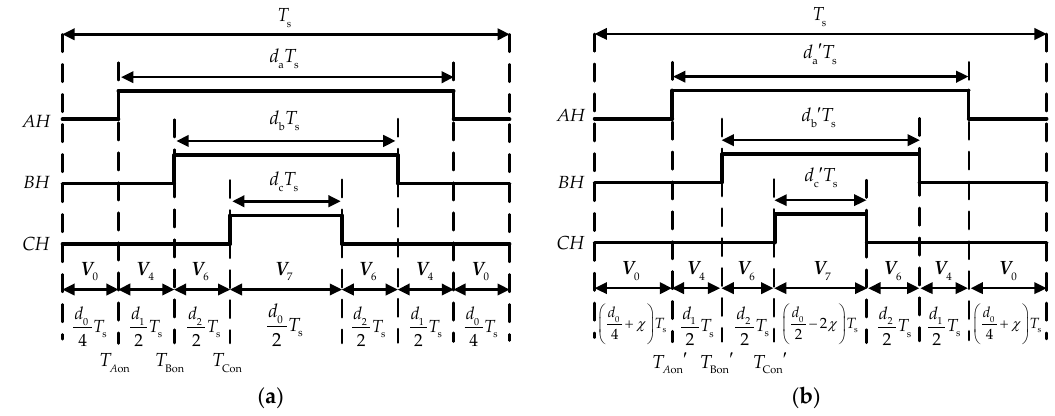
Figure 6. Switching signals for space vector pulse width modulation (SVPWM) control in sector I: ( a ) before adjustment; ( b ) after adjustment.